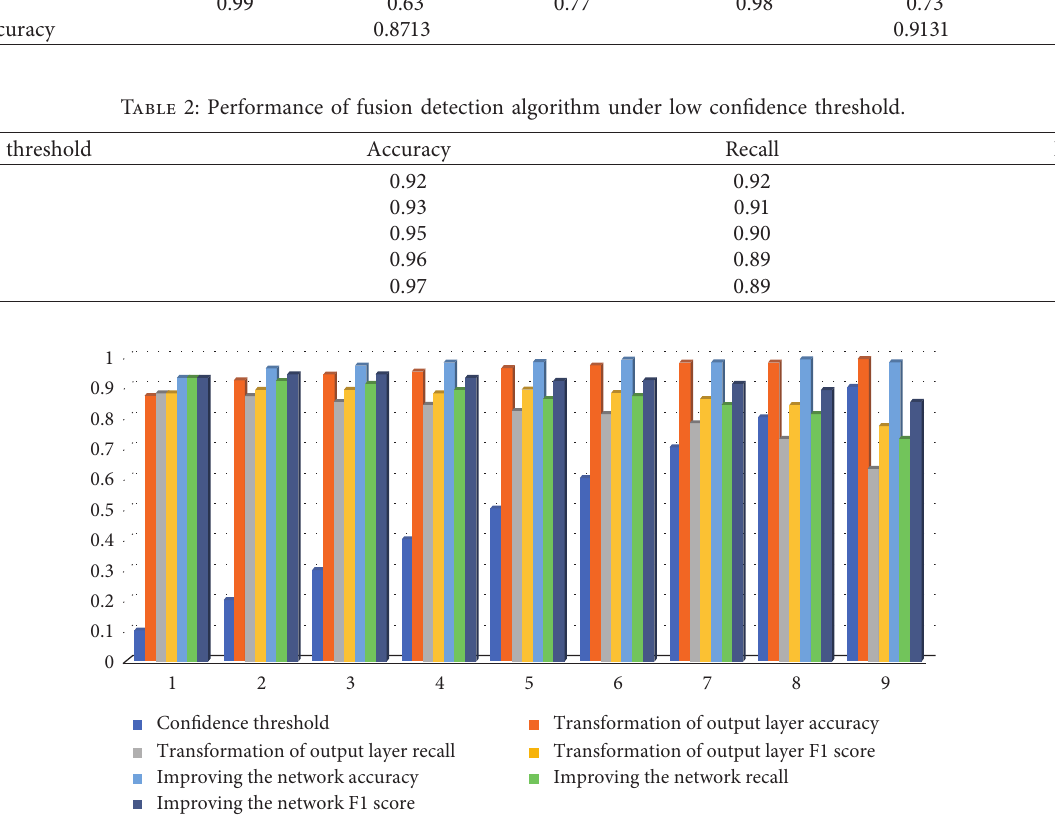
Figure 6: Performance comparison of models with different confidence